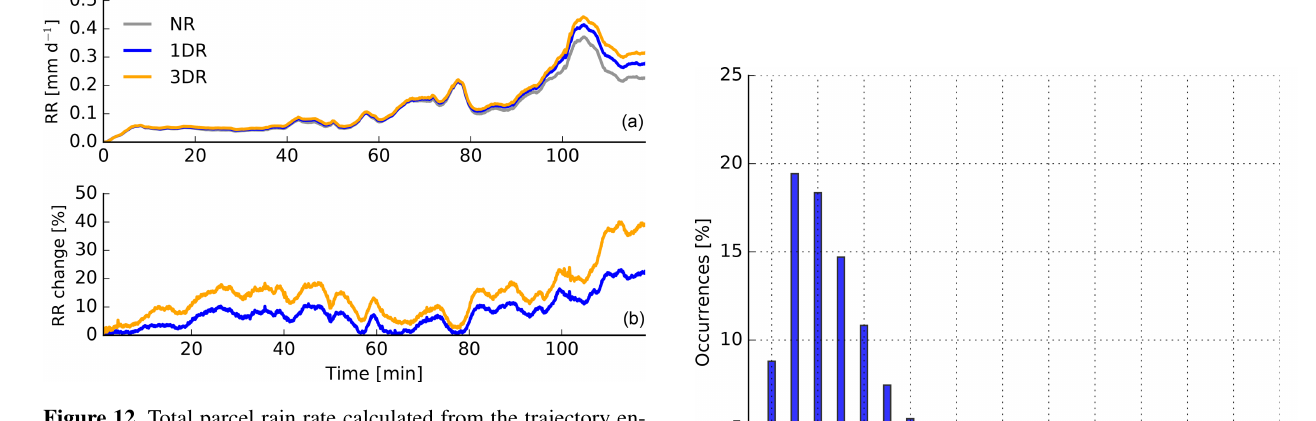
Figure 12. Total parcel rain rate calculated from the trajectory en- semble simulation (accounting for drop radii > 20µm). (a) shows the absolute rain rate for the NR, the 1DR and the 3DR cases. (b) shows the relative differences of 1DR simulation and the NR case, as well as 3DR simulation and the NR cases.